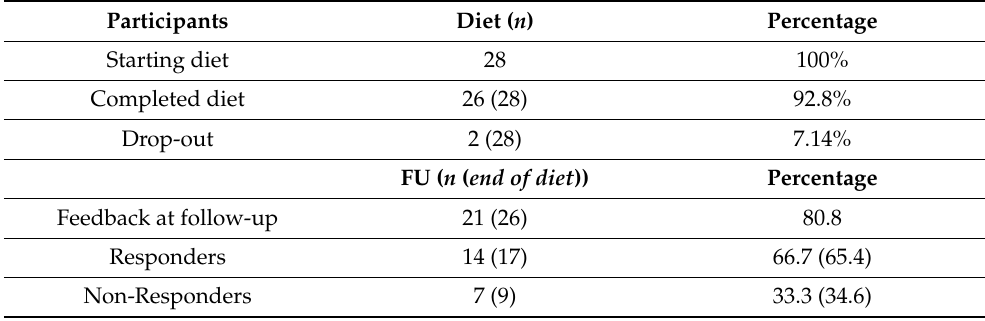
Table 2. Frequency distribution of children with ADHD that followed an oligoantigenic diet (FU = follow-up, 2–5 years after